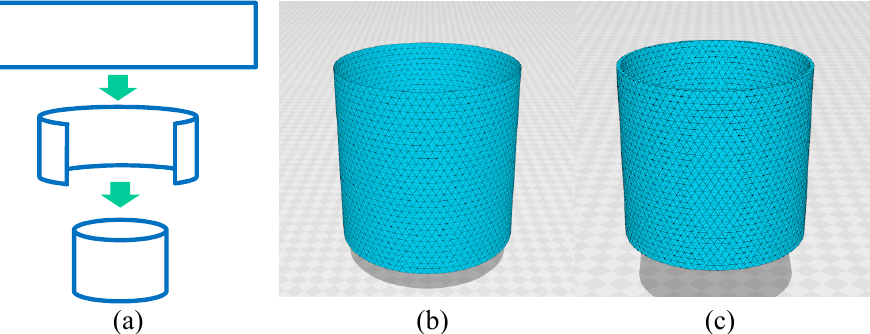
Figure 2. ( a ) A rectangular surface forms a cylindrical surface. Cylindrical lattices for ( b ) 2D and ( c ) 3D FG models. The lattices are composed of ( b ) triangles and ( c ) tetrahedrons. The total number of vertices are ( b ) N = 2511 and ( c ) N = 5022.